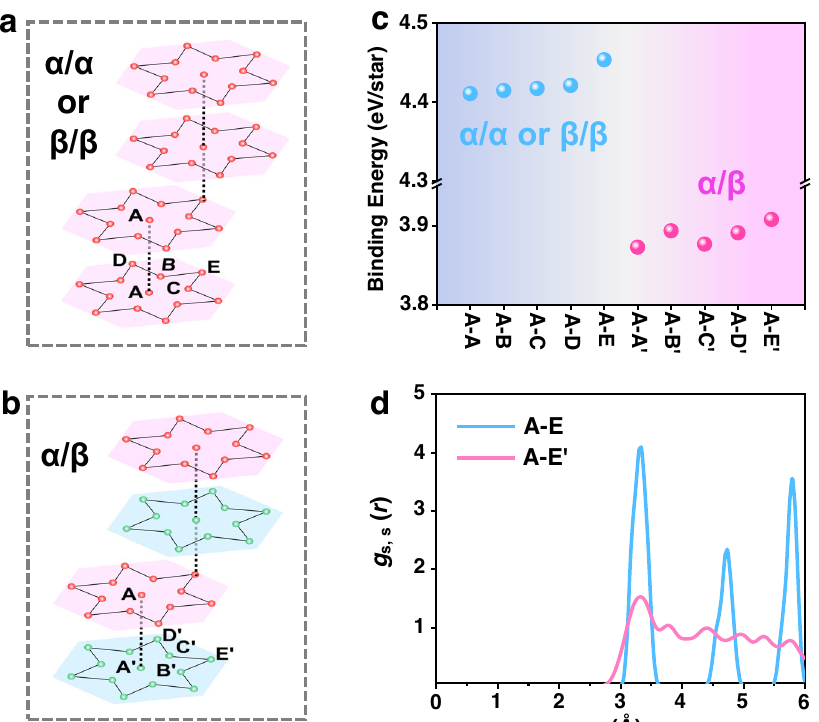
Fig. 4 | Analysis of the interlayer interaction for the same-chirality and opposite-chiralitystackingpatterns.a , b Schematicsofthestackingordersof1T- TaS 2 layers with a same chirality (take A-E stacking as an example) and b opposite chirality(takeA-E ′ stackingasanexample).Thepairedstackingpatternisadopted. c The binding energy ( E ib ) for fi ve stacking patterns of the same chirality (A-A, A-B,